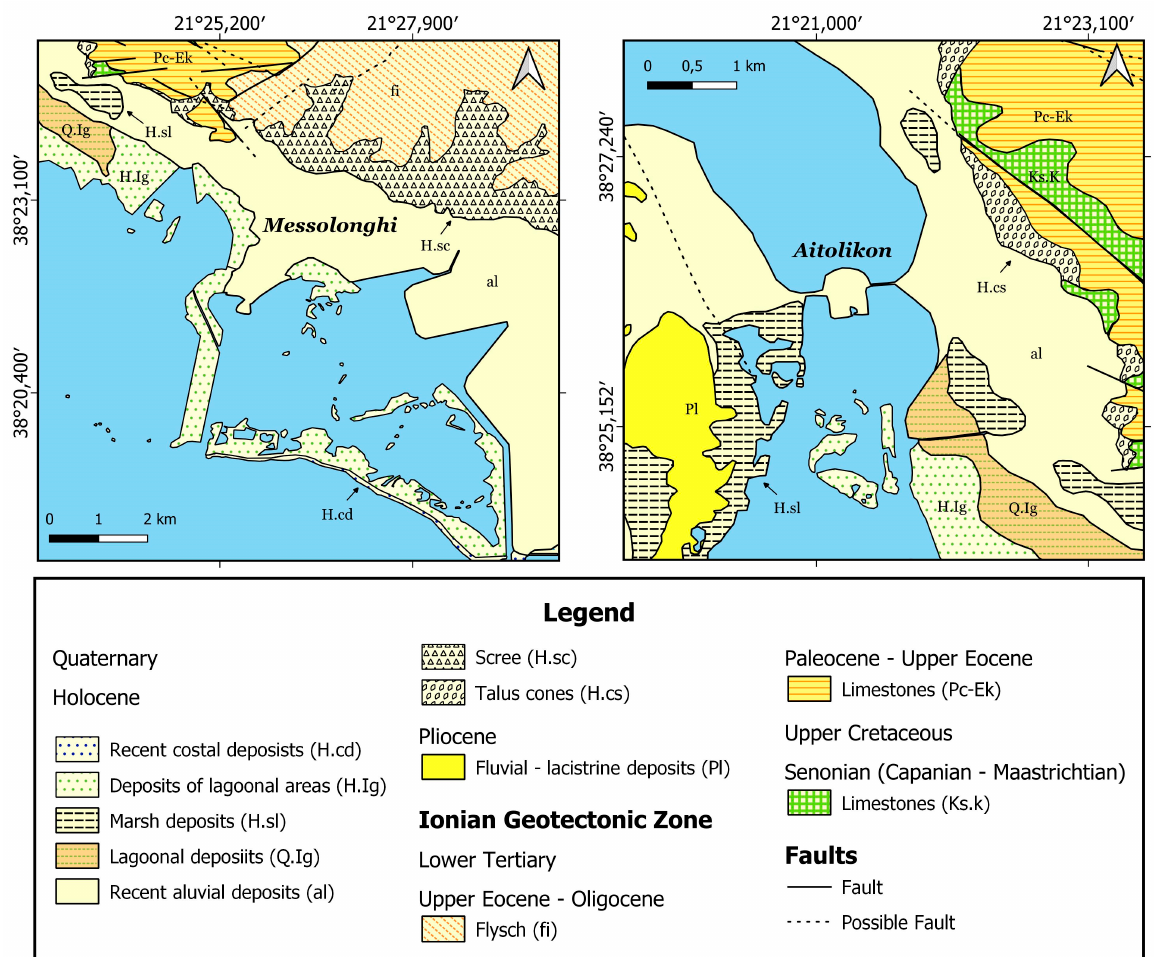
Figure 3. Geological maps of the Messolonghi ( left ) and Aitolikon ( right ) modified by Hellenic Survey of Geology & Mineral Exploration (HSGME) (1987–1990).